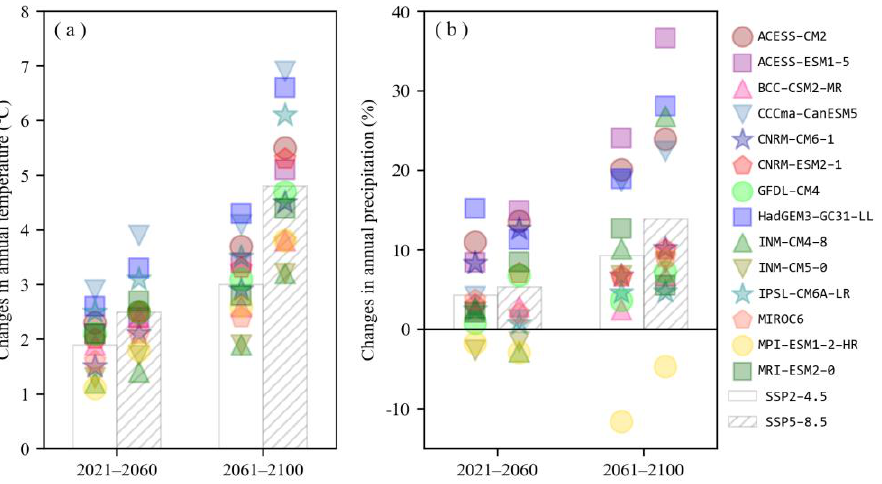
Figure 3. Figure 3. Projected changes in ( a ) annual mean temperature and ( b ) annual precipitation in the Fujiang River basin for 2021 – 2060 and 2061 – 2100 under 14 GCMs and 2 SSP-RCPs (relative to 1971 – 2010). Table 3. Projected changes in the ensemble mean and the ranges of climate and runoff in the Fujiang River basin for 2021–2060 and 2061–2100 under 14 GCMs and 2 SSP-RCPs (relative to